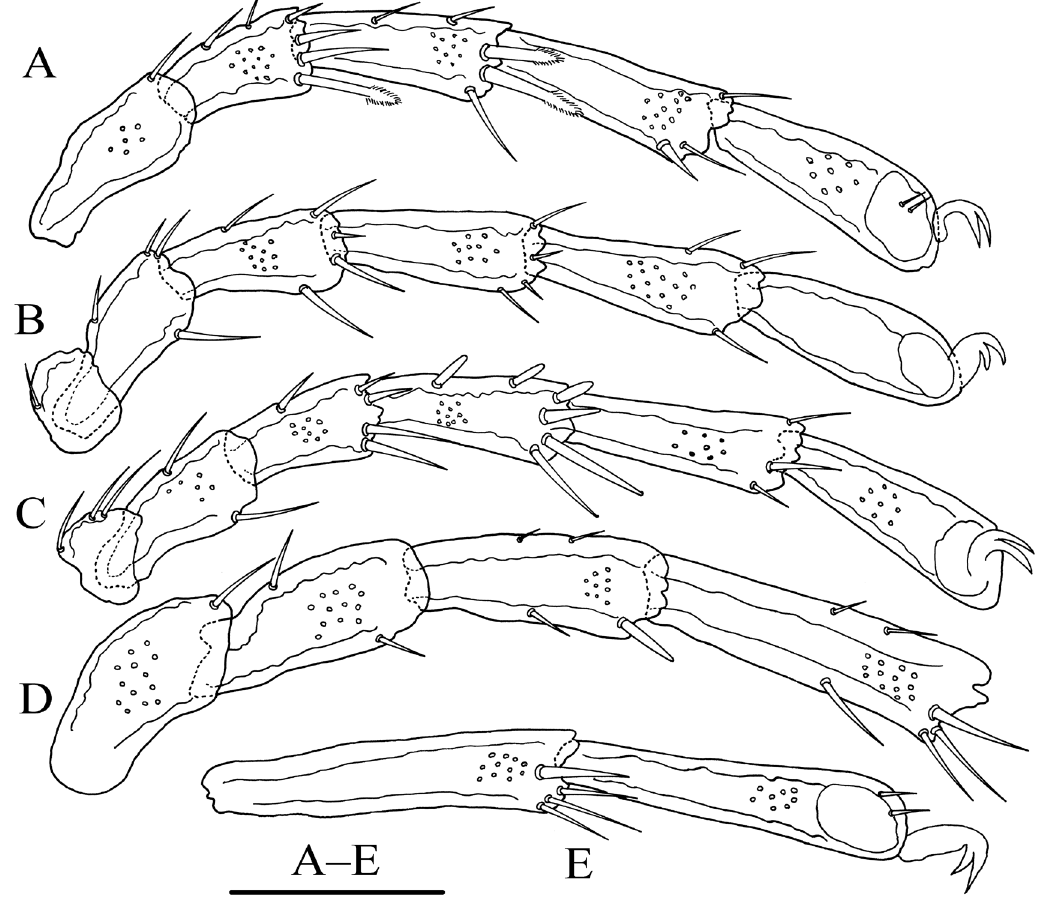
Fig. 10. Torrenticola wuyiensis Gu & Guo sp. nov., ♂ , holotype (FJ-TO-20180807). A . leg-I-2–6. B . leg-II. C . leg-III. D . leg-IV-1–4. E . leg-IV-5–6. Scale bar = 100